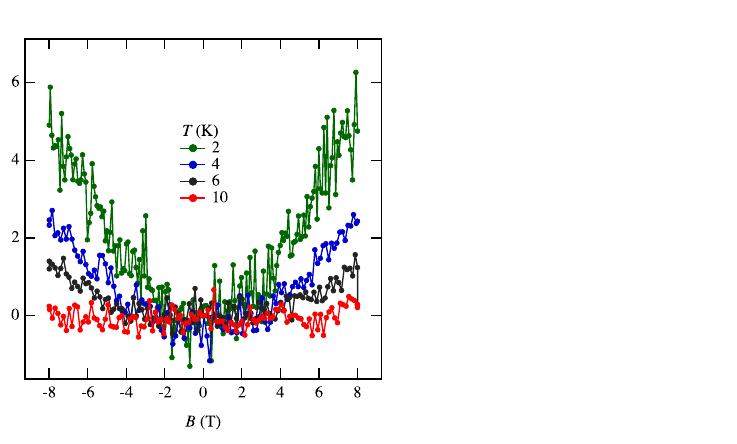
Figure A2. Temperature dependence of MR as a function of magnetic field at 11.8 GPa (sample 8).